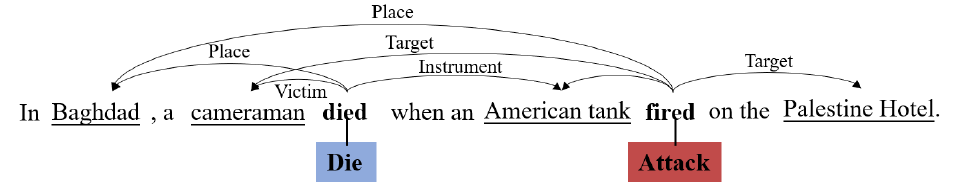
Figure 6. A sample of event